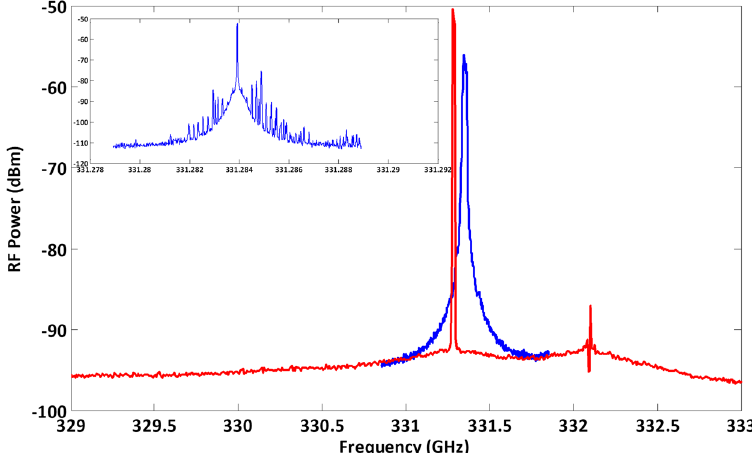
Figure 3. Electrical spectra of the photonic generated beat note at 330 GHz. The linewidth is reduced under the injection locking condition. The slight frequency difference between the free-running (blue) and the injection- locked (red) is caused by the optical power injected into the DBR lasers. RBW 2 MHz, VBW 3 kHz. The inset shows the injection-locked beat note with RBW 6 kHz.